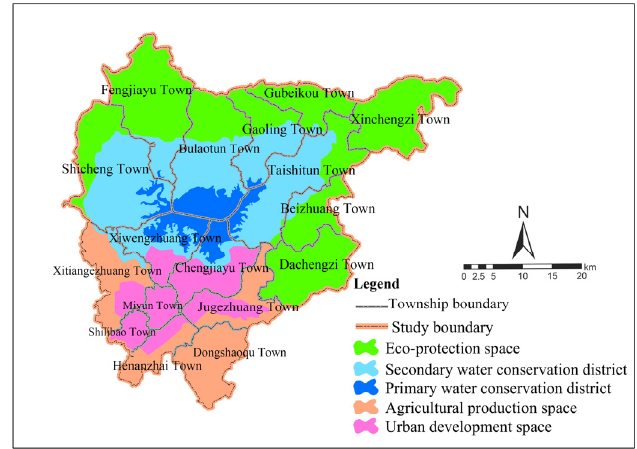
Figure 6. Main function zoning map of Miyun County.